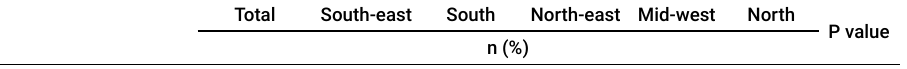
Table 3. Perception of dental professionals regarding the impact of pandemic considering the different Brazilian